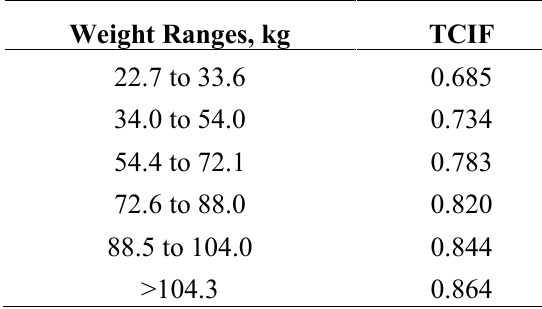
Table 3. Determination of total corn intake fraction (TCIF) in grower-finisher pig diets based on bodyweight 1